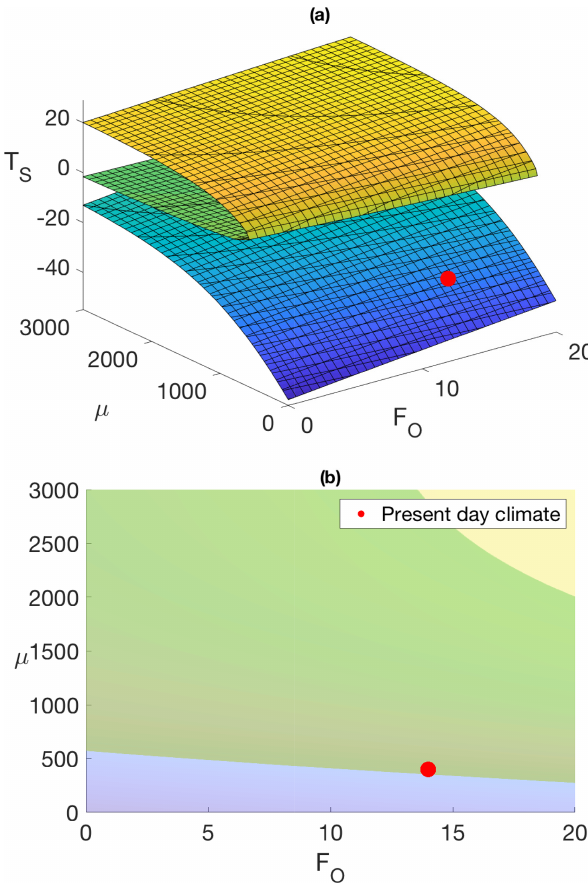
Figure 9. Energy balance model for the Antarctic. (a) 3-D equilib- rium manifold, (b) Projection of the fold bifurcations. The red dot locates today’s climate conditions on the cold surface.